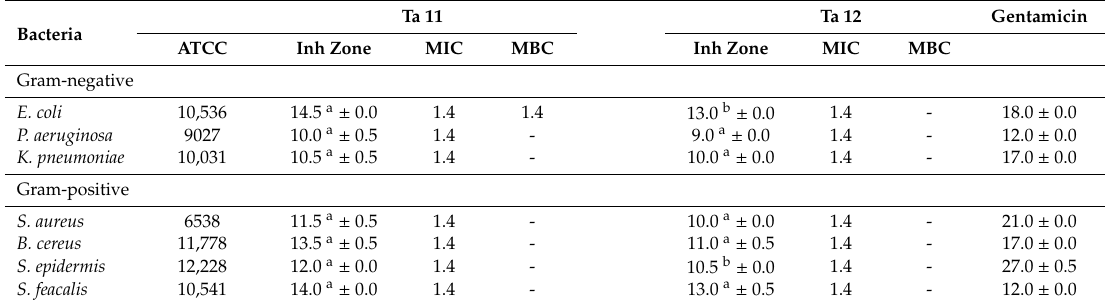
Table 6. Antibacterial activity estimated by diameter of inhibition (mm), minimum